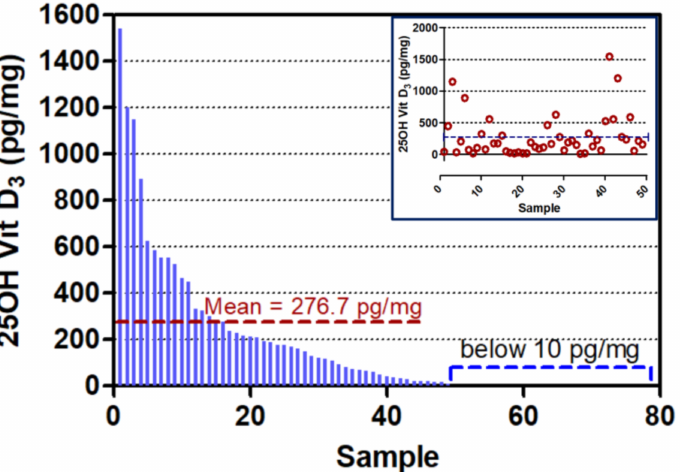
Figure 3. Individual 25 hydroxyvitamin D 3 levels in the hair of 70 young Emirati males (where only 50 hair samples had detectable (>10 pg/mg) levels of 25OHD 3 ). The inset shows the individual levels of 25OHD 3 in the 50